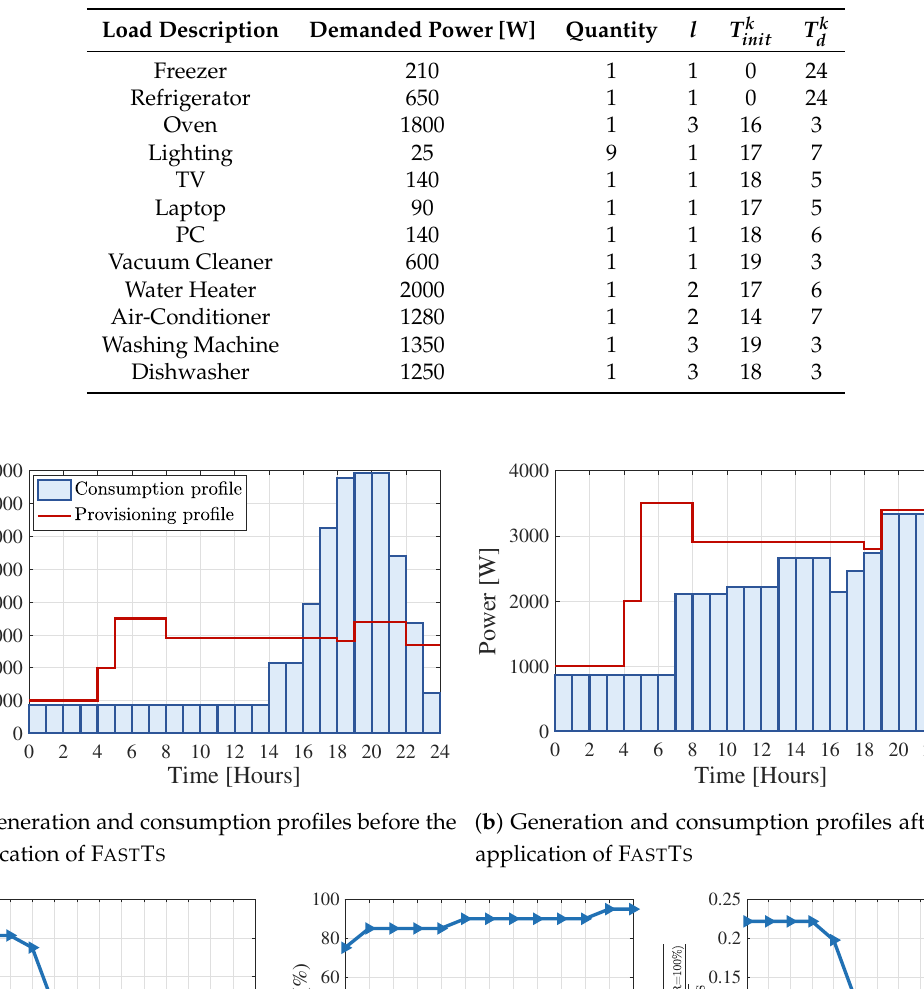
Table 6. Description of Home Energy Management Systems (HEMS) scenario that corresponds to the Case F in Table 5.